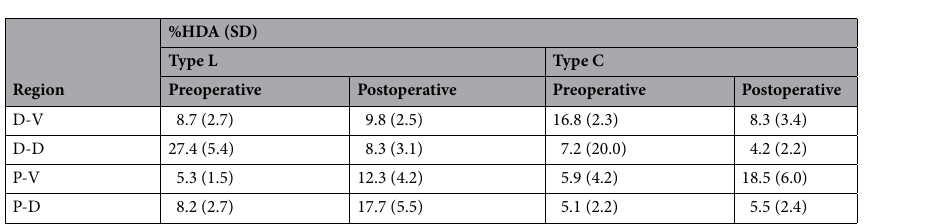
Table 1. Percentage of the high-density area with SDs of each region in the sigmoid notch according to the type of bony morphology. D-V Distal-volar, D-D Distal-dorsal, P-V Proximal-volar, P-D Proximal-dorsal, %HDL Percentage high-density area, SD Standard